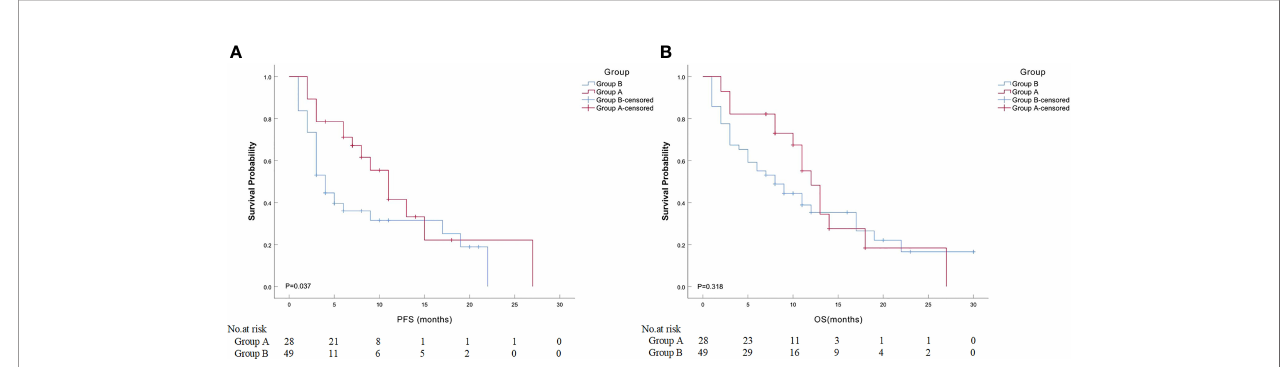
FIGURE 2 | Comparison of median PFS or OS between ASTRI-NSCLC patients in groups A and B. (A) The estimated median PFS was 11.0 months for patients in group A, while that was 4.0 months for patients in group B. (B) The estimated median OS was 12.0 months for patients in group A, while that was 8.0 months for patients in group (B) PFS, progression-free survival; OS, overall survival; ASTRI-NSCLC, advanced standard treatment-refractory/ineligible non-small cell lung